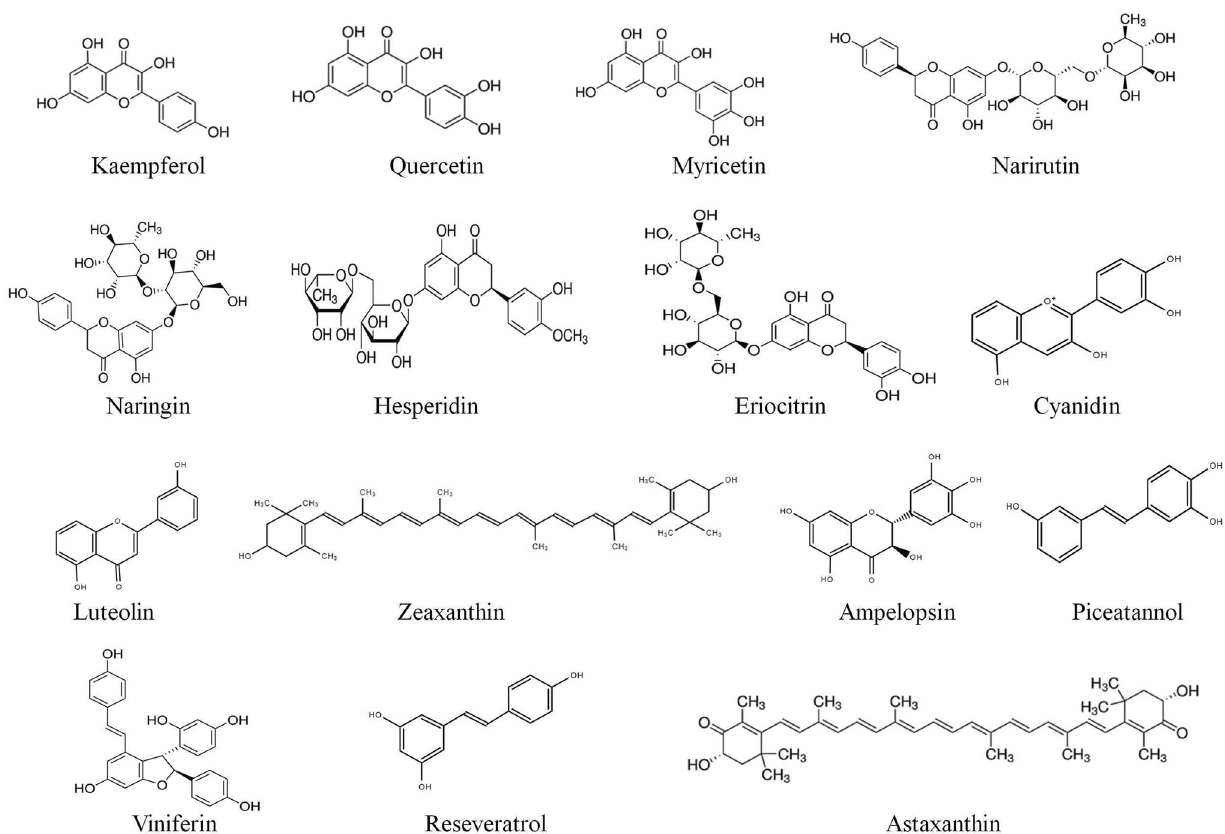
Fig. 3 Chemical structures of major fruit bioactive